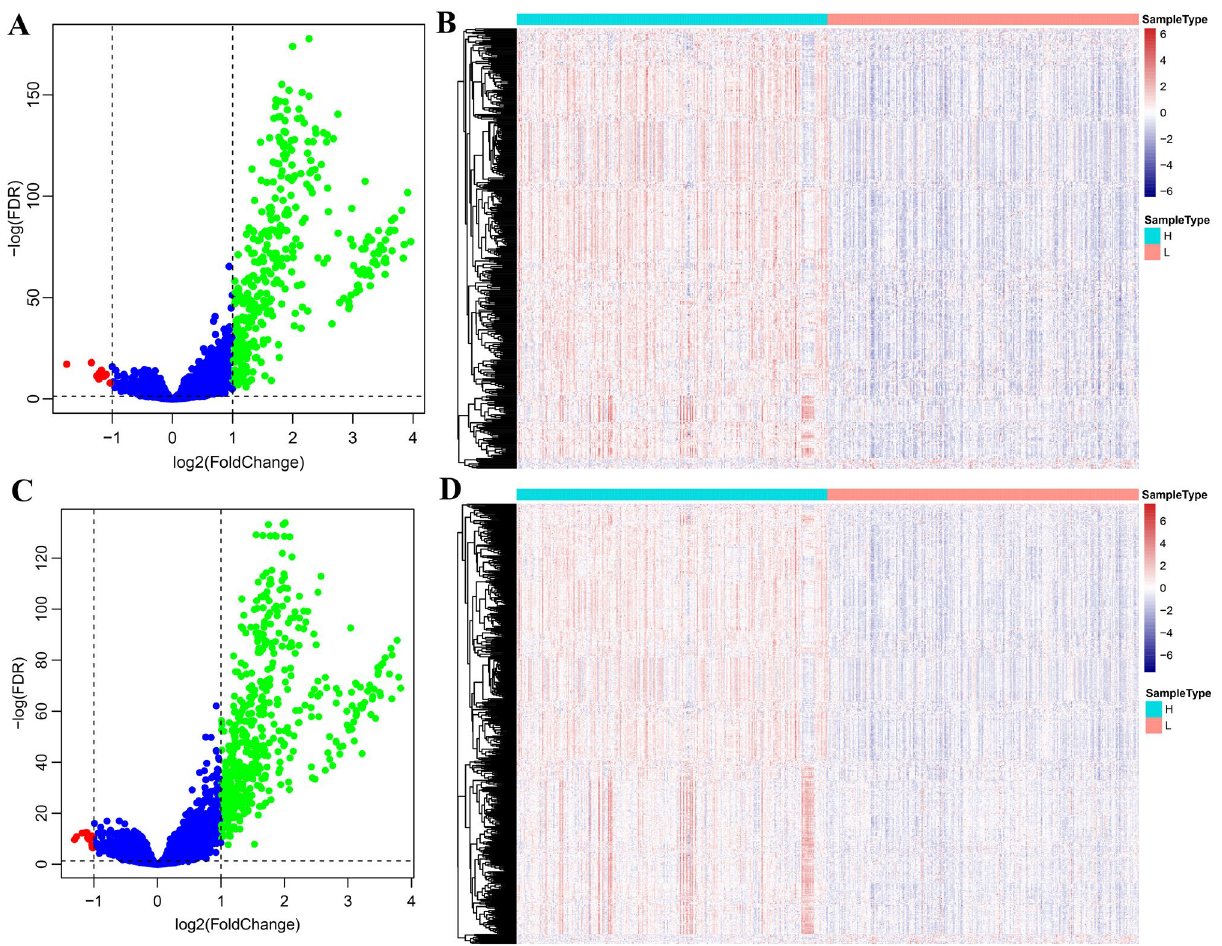
Figure 8. Gene expression profile of high- and low-ImmuneScore /ESTIMATEScore groups. ( A , C ) Volcanic maps. ( B , D )